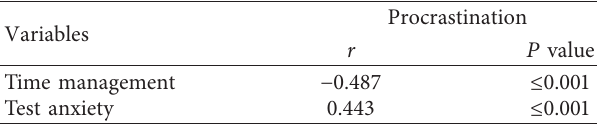
Table 3: Correlation coefficients between study variables.